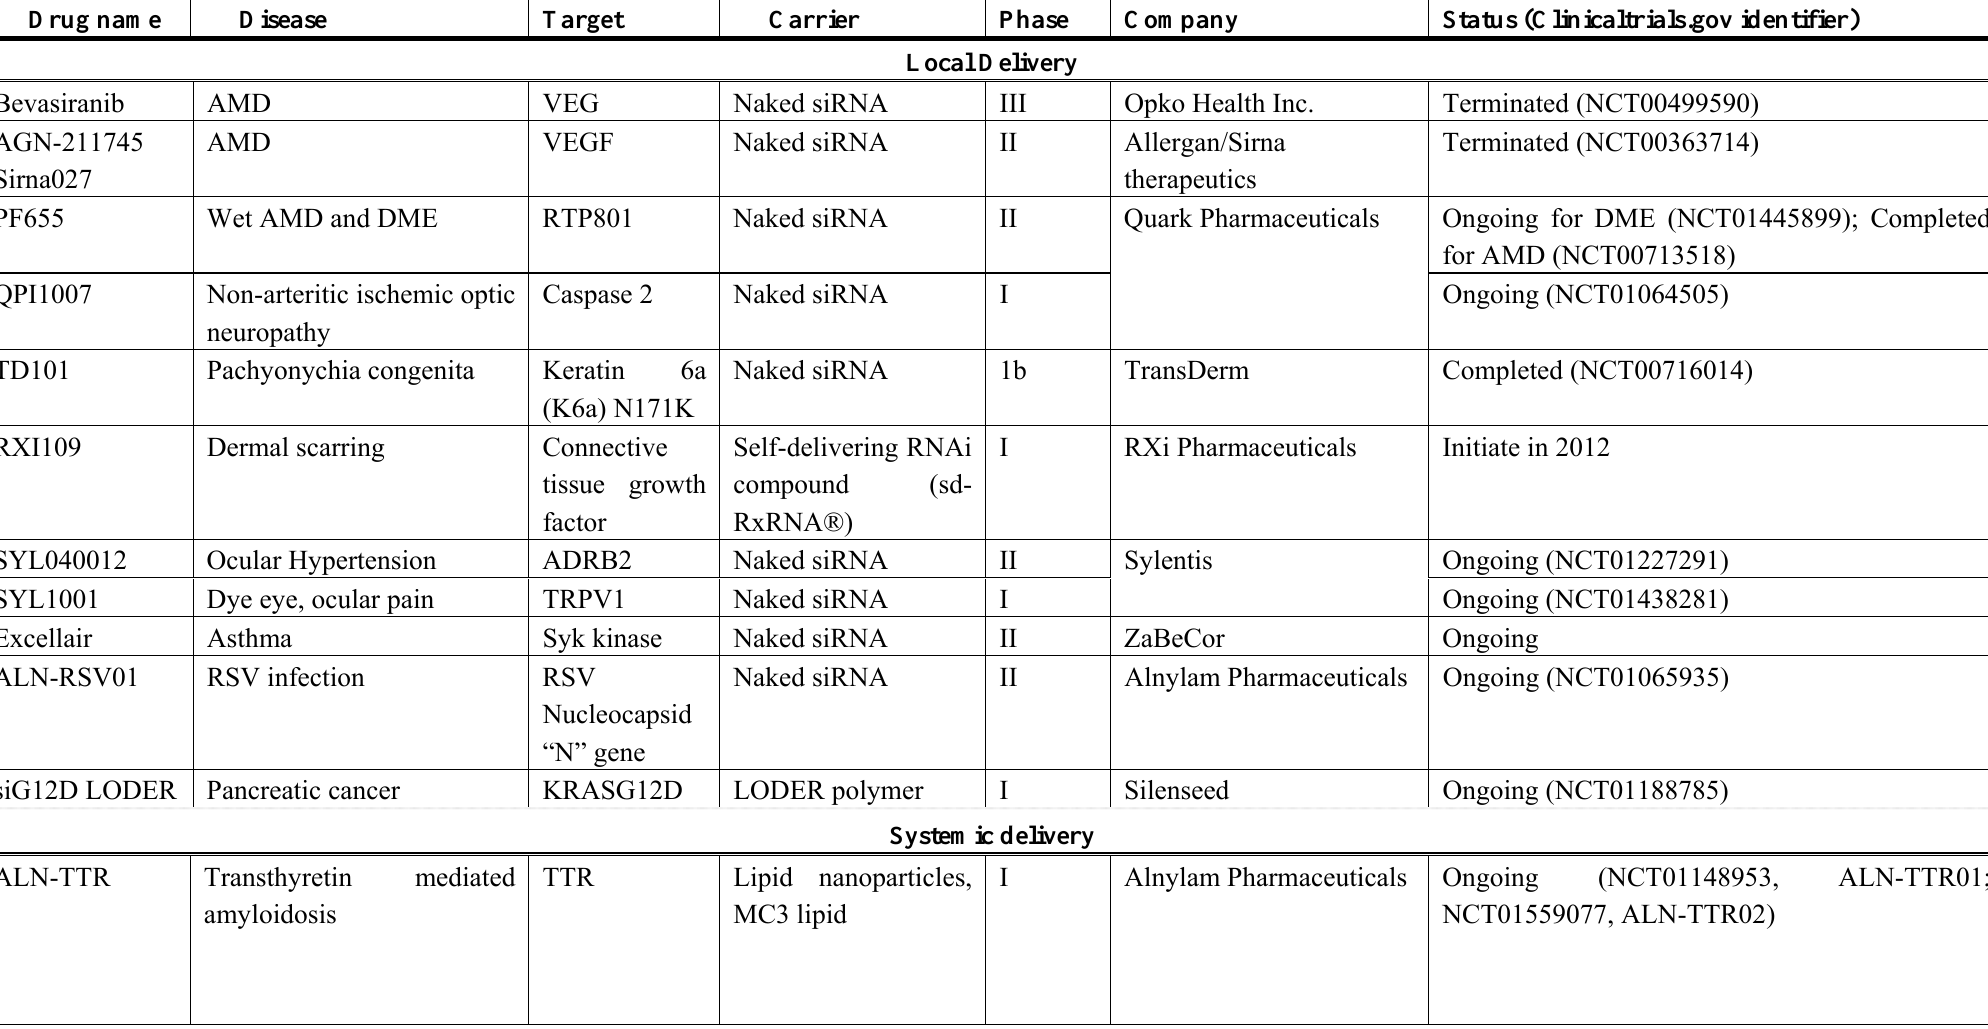
Table 1. Non-viral delivered siRNAs in the clinical